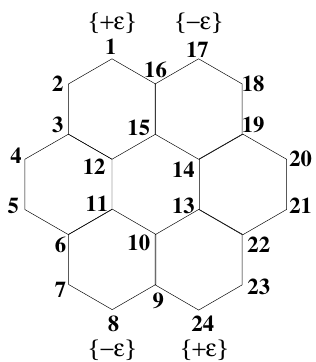
Figure 2. (Color online) Schematic diagram of the coronene molecule. The sites of substitution in substituted coronene are also indicated; + (cid:101) represents a donor site, while − (cid:101) represents an acceptor